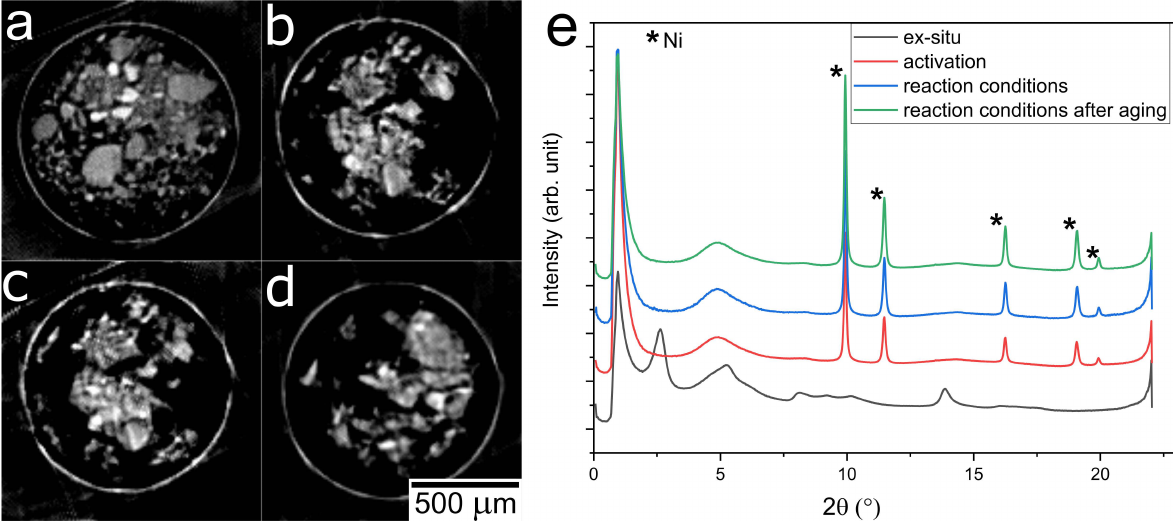
Figure 3. Summed intensities of all reflections for slices at the following conditions: ( a ) initial state; ( b ) activation; ( c ) reaction conditions; ( d ) reaction conditions after thermal aging. ( e ) Normalized sum XRD patterns of the whole measured slices of the Ni/Al 2 O 3 catalyst, representing total signal from all pixels of the XRD tomography images. XRD patterns recorded at λ = 0.0354